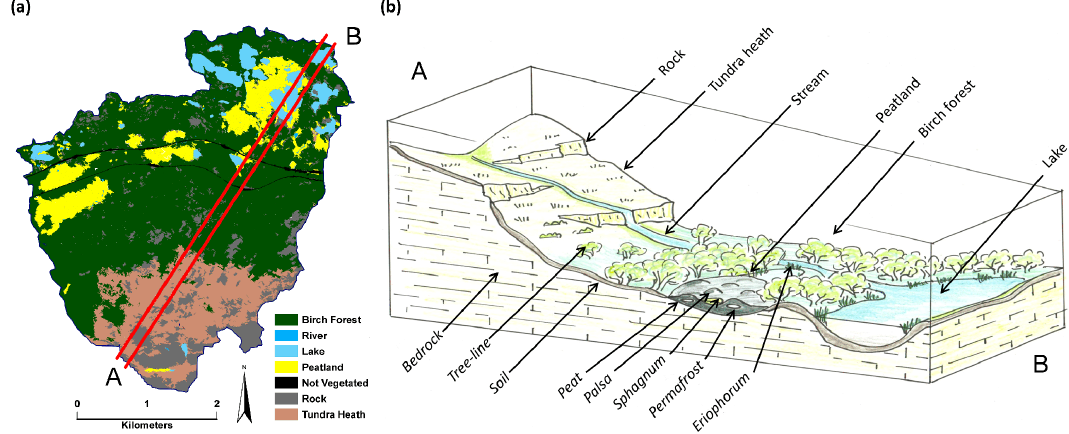
Figure 2. Object-based vegetation classification map of the Stordalen catchment (a) and schematic of land-cover types and features of the approximate transect A–B in (b)